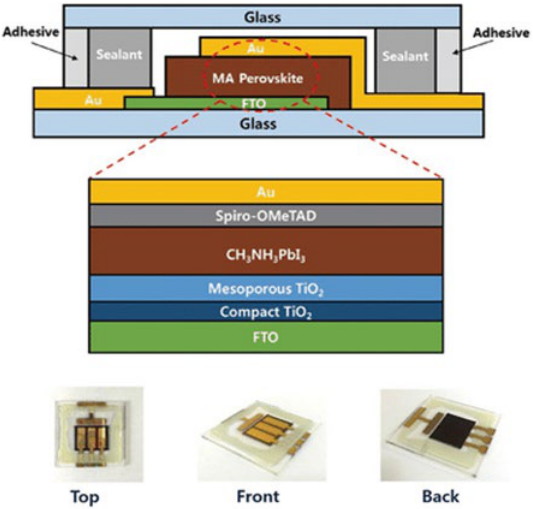
Figure 16. Simplified schematic images of PSC encapsulation, the PSC device architecture, and low-resolution images of the actual PSC device from the top, front, and back [92].